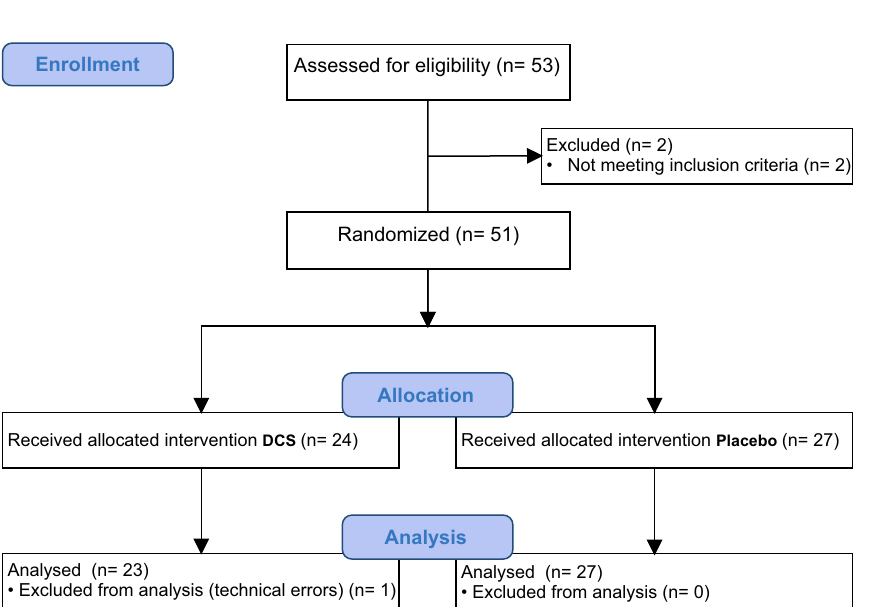
Figure 2. Flow-chart of participants’ movement through the trial, based on CONSORT